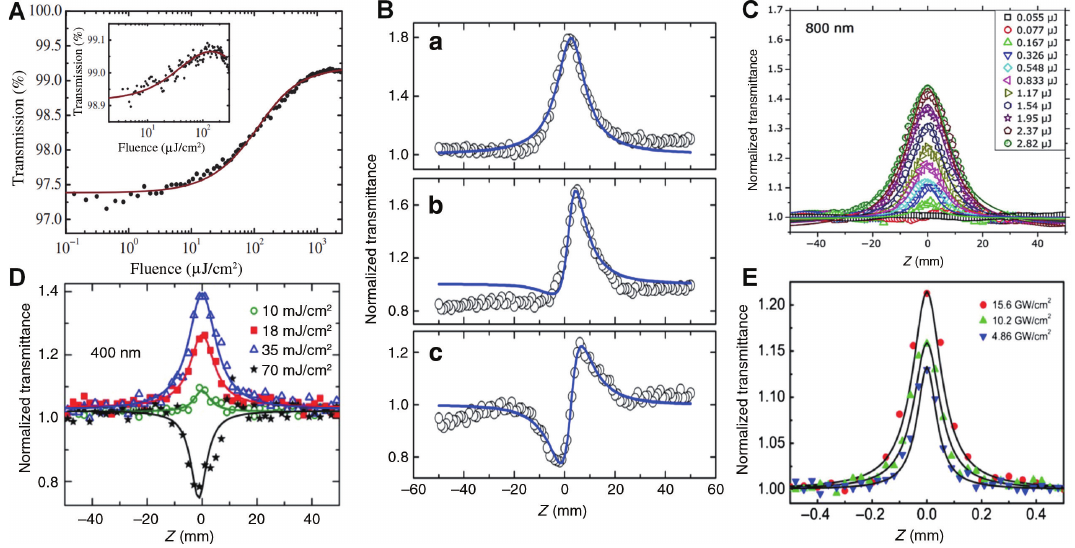
Figure 4: Nonlinear saturable absorption properties of nanomaterial SAs in the visible region. (A) Transmittance of monolayer graphene at 800 nm; inset: SWCNT SA. (B) OA Z-scan results of a TI: Bi (open aperture), (b) far-field (closed aperture), and (c) typical shape of a Z-scan trace for Kerr nonlinearity. (C) OA Z-scan trace of MXene Ti C T at 800 nm. (D) OA Z-scan results of MoS 3 2 x